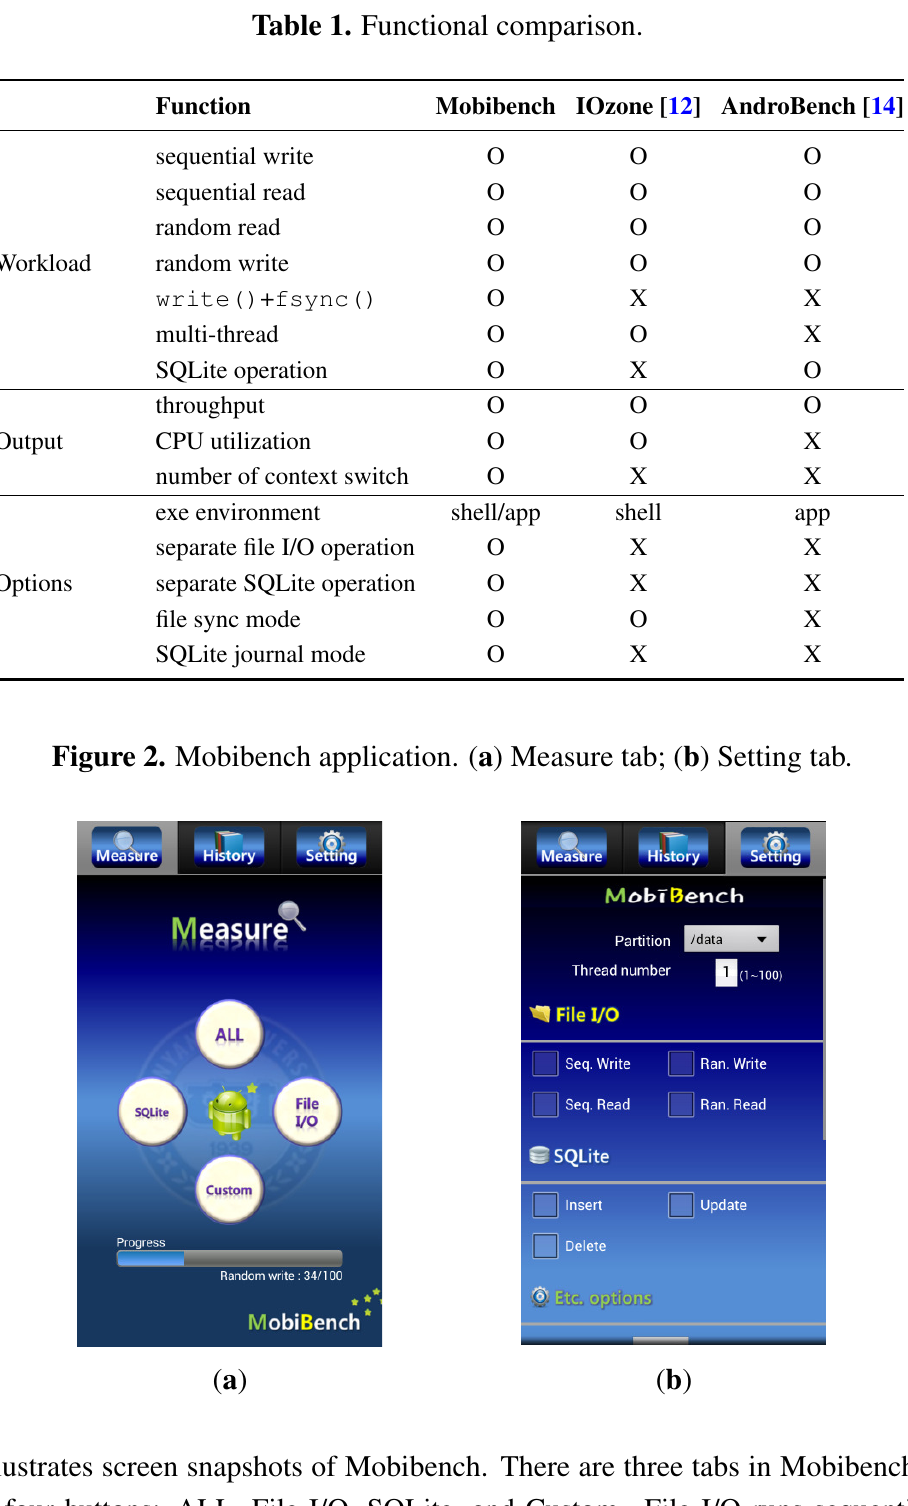
Table 1. Functional comparison.